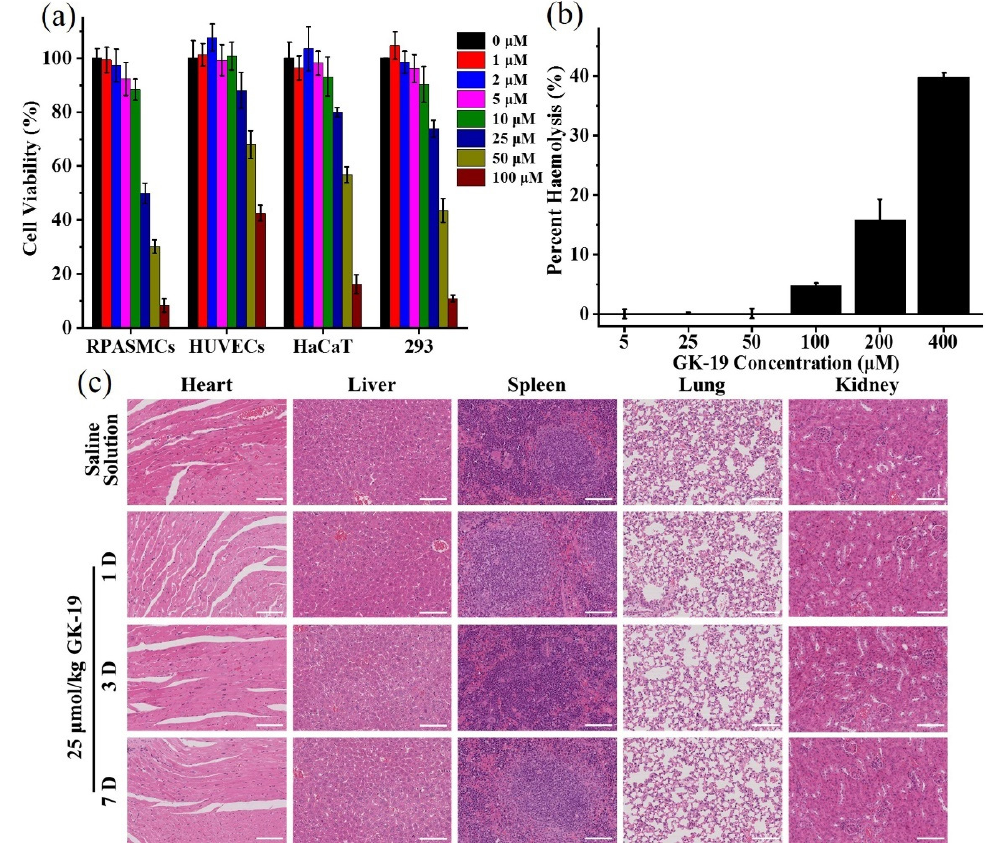
Figure 3. ( a ) Toxicity of GK-19 to mammalian cells. RPASMCs, HUVECs, HaCaT and 293 cells were cultured in mediums containing different concentrations of GK-19 (0–100 μ M) for 48 h. (n = 5). GK-19 caused a negligible toxicity to mammalian cells at effective antimicrobial concentrations. ( b ) Hemolytic activity of GK-19 on rat erythrocytes. ( c ) Histology analysis of various organs of the mice treated with saline solution or GK-19 (25 μ mol/kg), respectively. The heart, liver, spleen, lungs and kidneys were harvested on days 1, 3 and 7. No observable tissue damage, necrosis or inflammation were observed. Scale bar: 200 μ m.